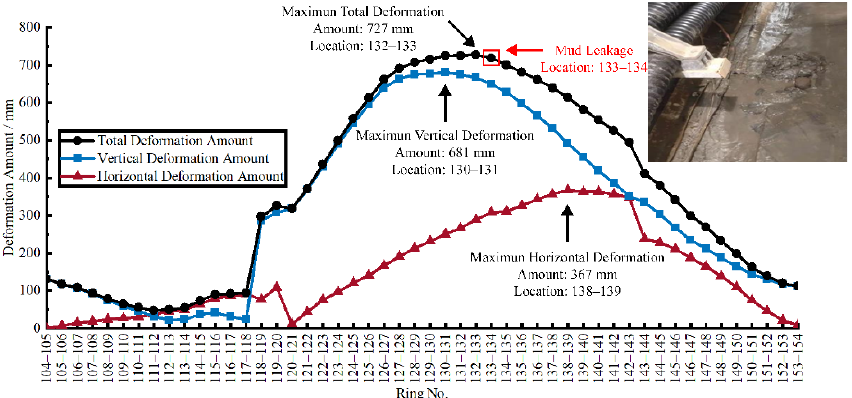
Figure 10. Correlation between the amount of deformation and tunnel defect.